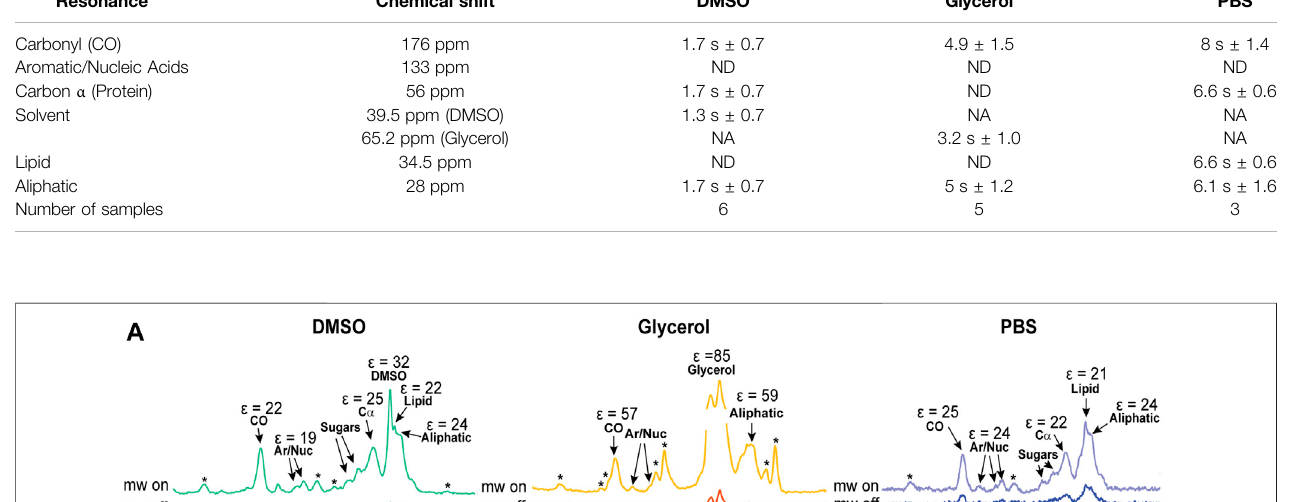
TABLE 1 | T B for different cellular resonances preserved under various preservation methods. Resonance